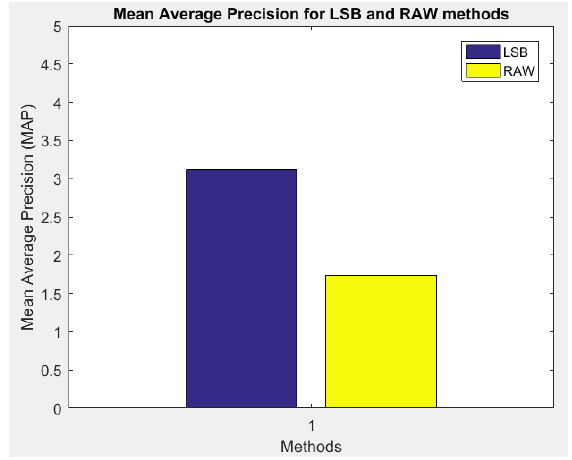
Figure 6. Mean average precision of Users’ feedback for LSB and RAW